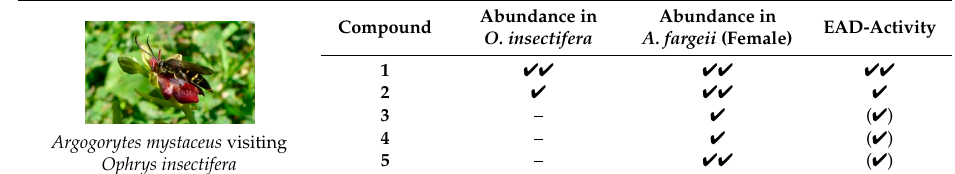
Table 1. Occurrence of semiochemicals in Ophrys insectifera (SPME extracts) and Argogorytes fargeii females (solvent extracts), with electroantennographic responses in A. mystaceus males.